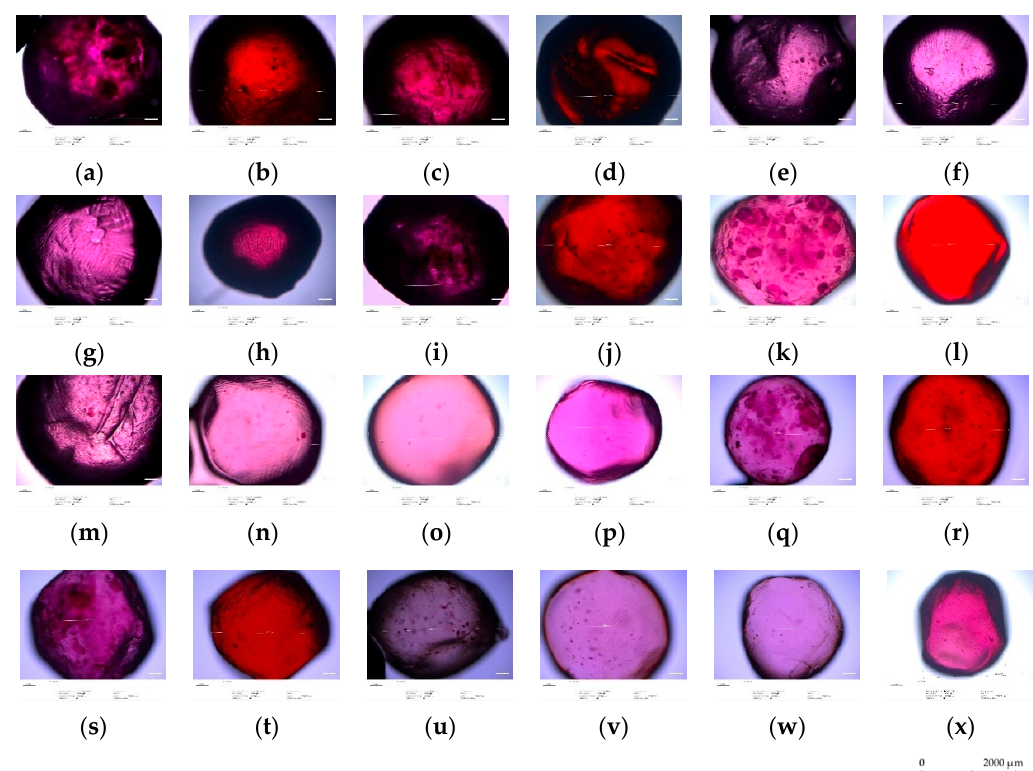
Figure 1. Microscopic images of microspheres coating chokeberry concentrate, made of various coating materials: ( a )